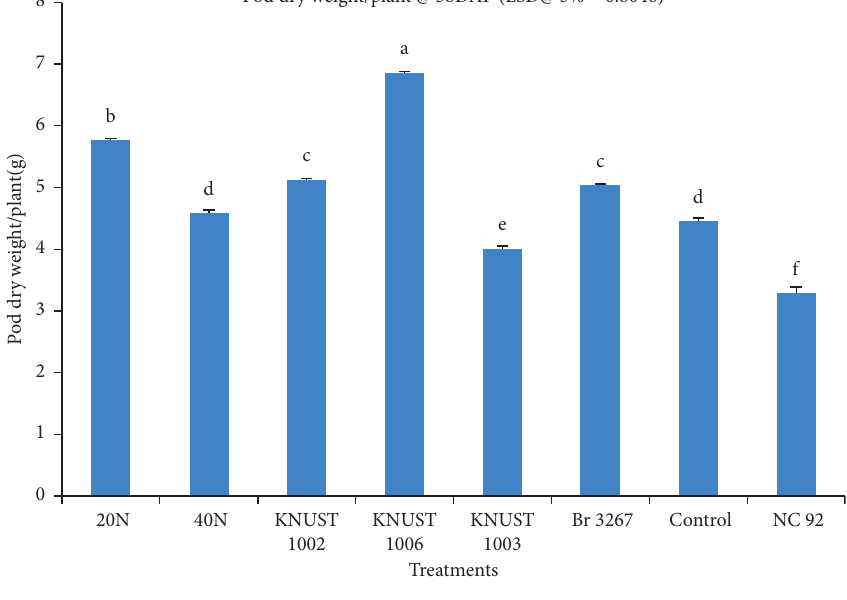
Figure 2: Effects of rhizobial inoculation and N fertilizer application on pod dry weight of cowpea. Bars with different letters denote significance at P < 0 . 05. Error bars denote the standard error of means. Means comparison was conducted using least significant